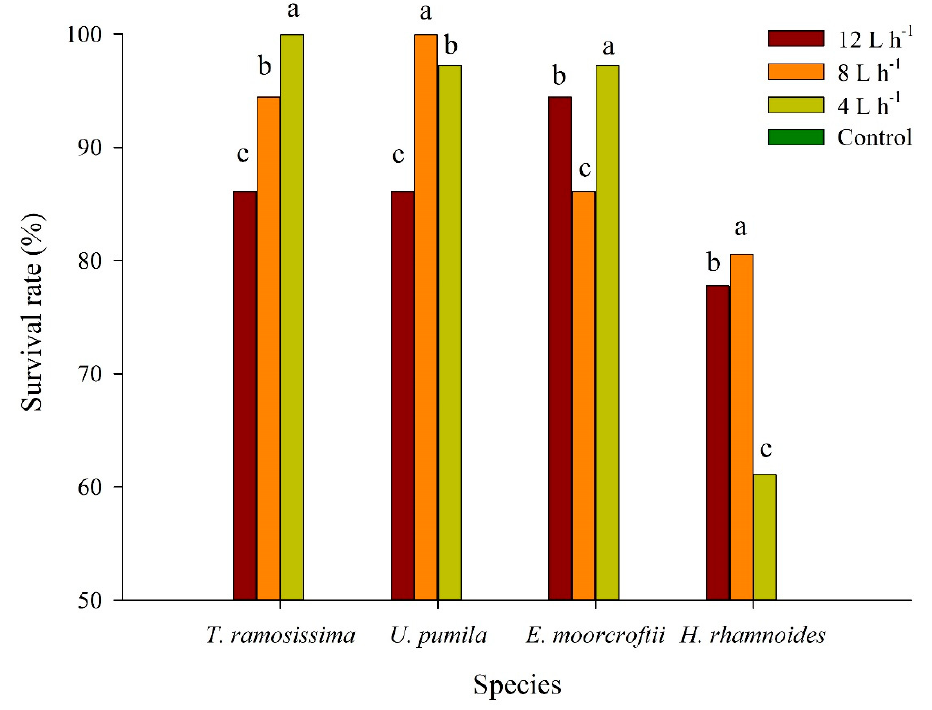
Figure 3. Survival rate of Tamarix ramosissima , Ulmus pumila , Elaeagnus moorcroftii and Hippophae rhamnoides across different irrigation treatments (i.e., control, 12, 8, and 4 L h − 1 ) measured in 2019. The control had 100% mortality rate in all species. Different lowercase letters within each species indicate significant differences among the treatments at α =